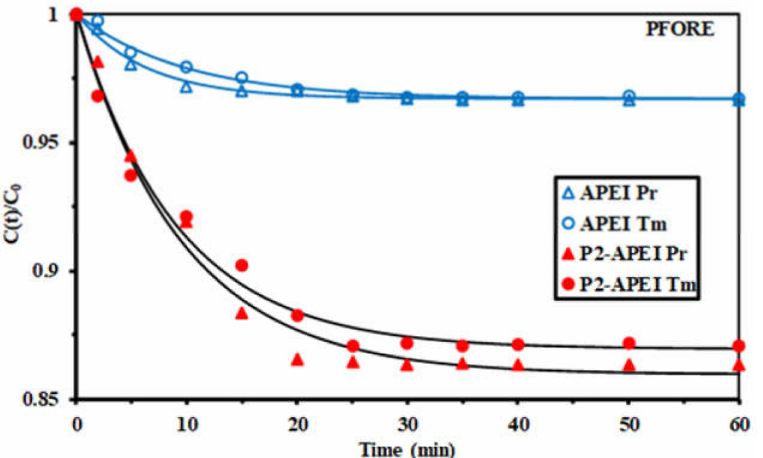
Figure 6. Pr(III) and Tm(III) uptake kinetics using APEI and P2-APEI sorbents from binary solutions (C 0 : 50 mg L − 1 ; Sorbent dosage, SD: 0.25 g L − 1 ; pH 0 : 5; pH eq : 4.87 and 4.62 for APEI for Pr(III) and Tm(III), respectively; 3.24–3.12 for Pr(III) and 3.44–3.47 for Tm(III) with P2-APEI; T: 22 ± 1 ◦ C; solid lines: modeling with